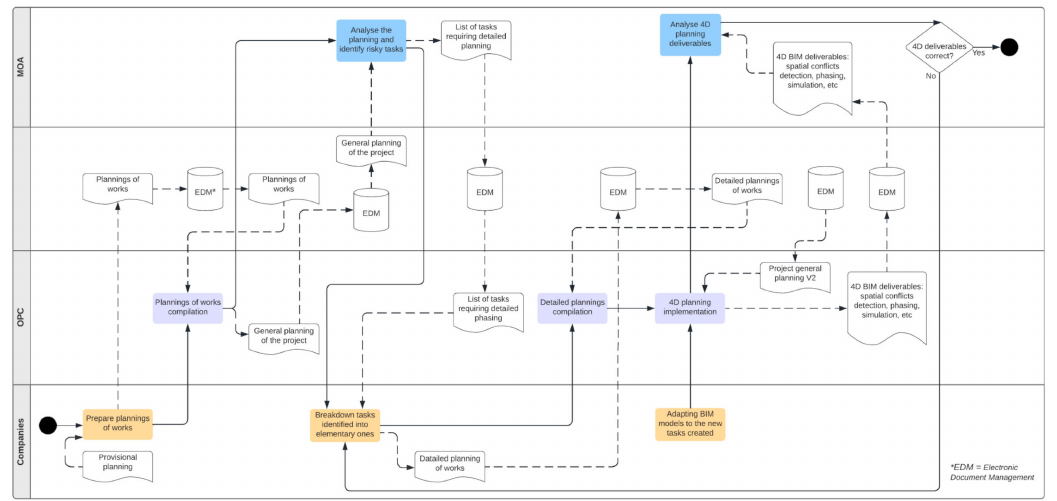
Figure 8. Summary of Phase 2’s process - Design of the project schedule adapted for the use of 4D BIM.